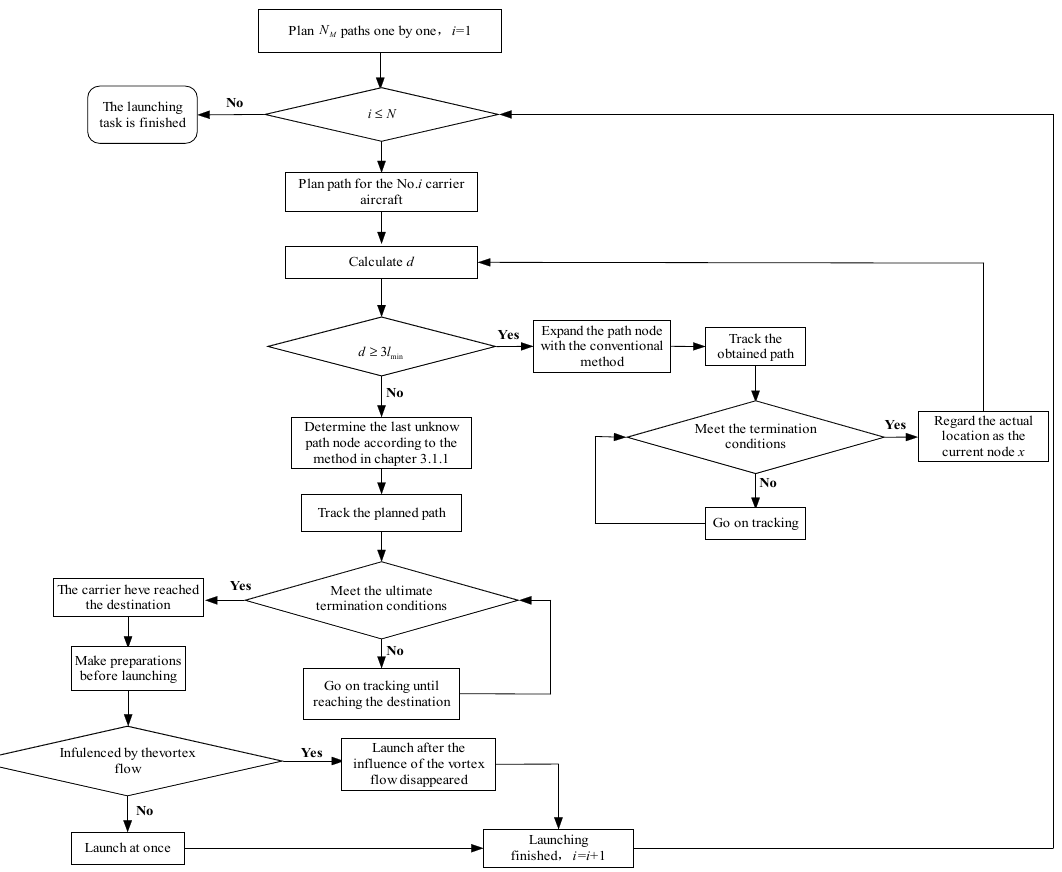
Figure 6. Flow of the path planning algorithm.